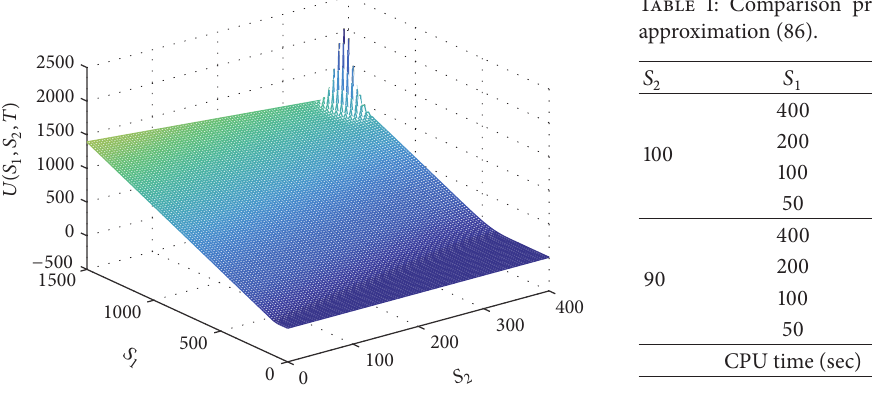
Figure 3: Stability condition is broken.